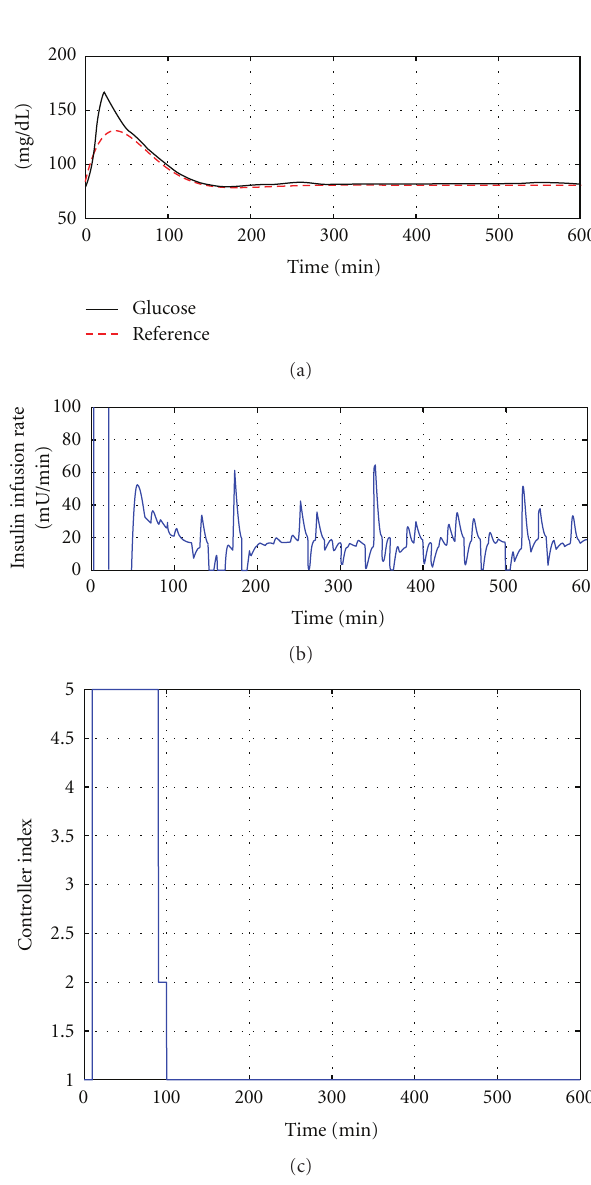
Figure 6: Unfalsified control: glucose monitoring, insulin control and controller switching.